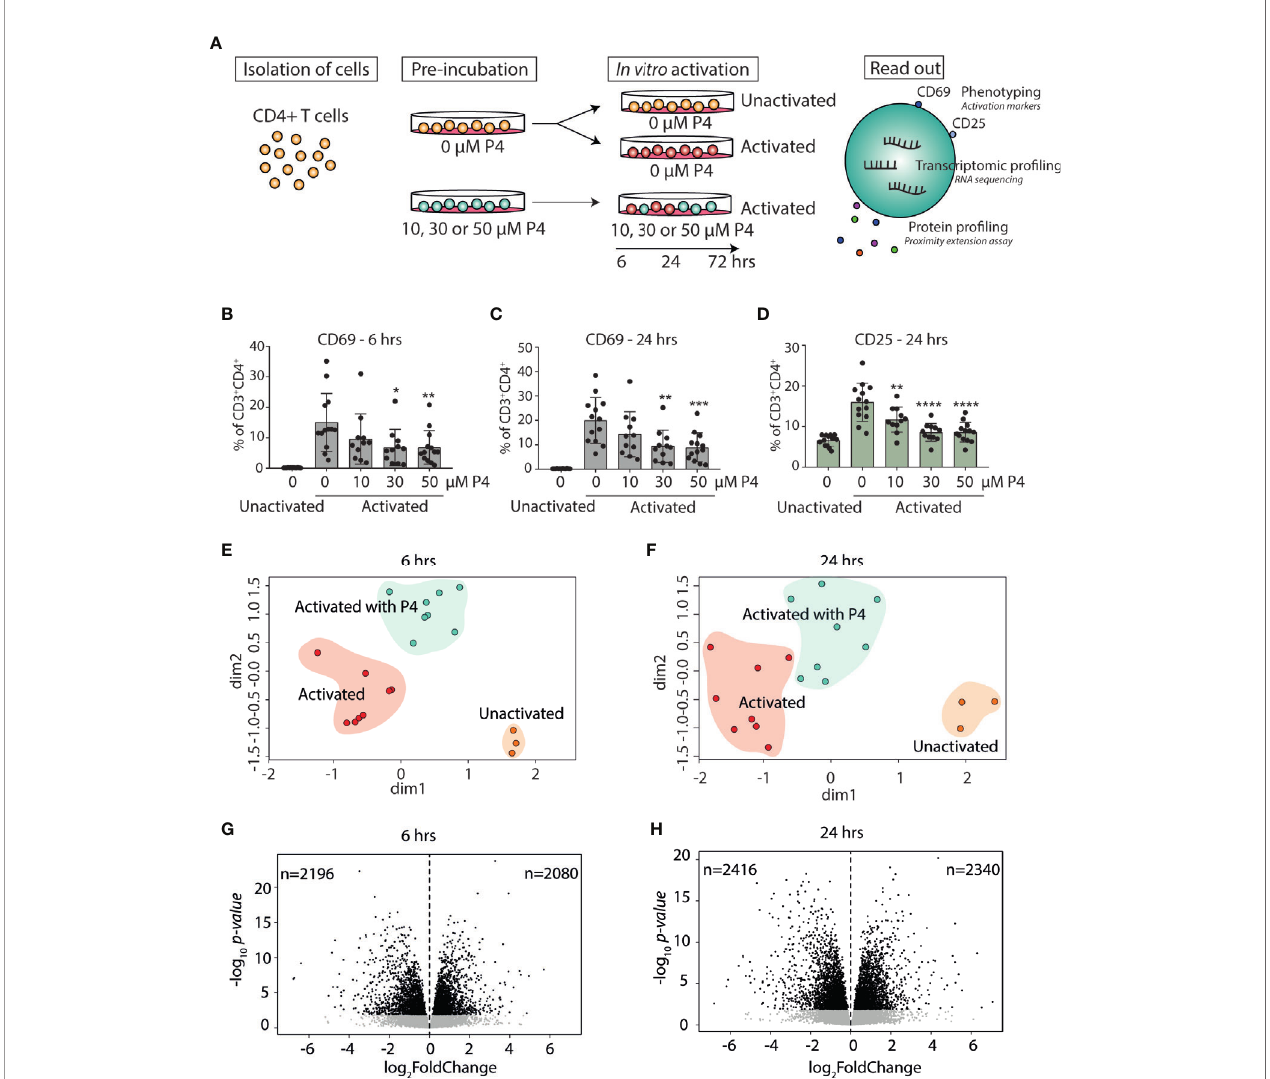
FIGURE 1 | Progesterone dampens T cell activation and induces transcriptomic changes in activated CD4 + T cells. (A) Primary human CD4 + T cells were isolated from healthy non-pregnant women (n=13) and pre-incubated with or without different concentrations (10, 30 and 50 µM) of P4 for 20 hrs and then cultured unactivated or activated in vitro with plate-bound anti-CD3 and anti-CD28 antibodies in the presence or absence of P4 for 6-24-72 hrs. Samples cultured for 72 hrs were only used for measurement of secreted proteins. The effect of P4 on T cell activation was evaluated by fl ow cytometry, RNA sequencing and proximity extension assay of secreted proteins in culture supernatants. (B – D) The effect of P4 on T cell activation markers CD69 (6 and 24 hrs) and CD25 (24 hrs only) was analyzed by fl ow cytometry (n=11-13). Bar graphs shows the percentages of CD4 + T cells expressing the T cell activation markers. Mean ± standard deviation is shown. *p ≤ 0.05, **p ≤ 0.01, ***p ≤ 0.001, ****p ≤ 0.0001. (E, F) Multidimensional scaling analysis of gene expression data generated by RNA-sequencing (n=3 unactivated, n=8 activated with and without 50 µM P4). The groups are highlighted with background color for schematic purposes only. (G, H) Volcano plots of the transcriptomic analysis of the differentially expressed genes in CD4 + T cells activated in the presence of P4 as compared to absence of P4. Black dots FDR ≤ 0.05. P4,